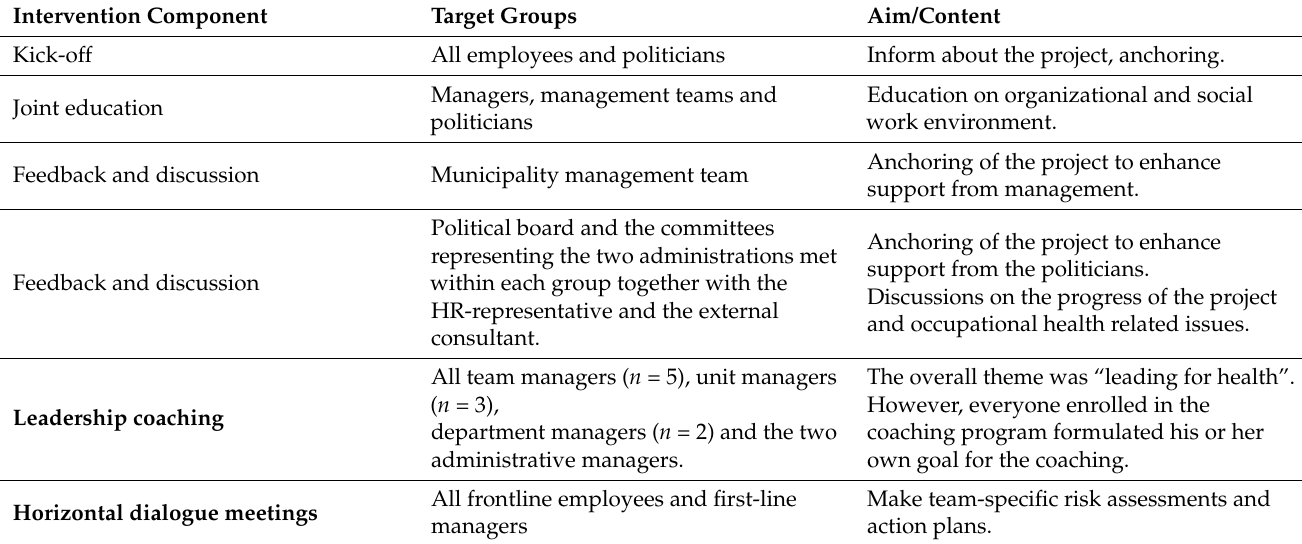
Table 1. Target groups and, aim and content for all intervention